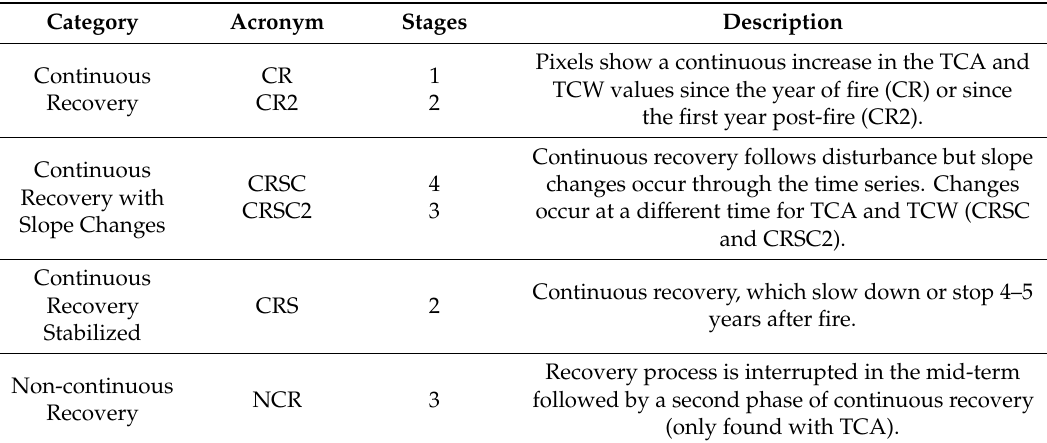
Table 3. Recovery categories